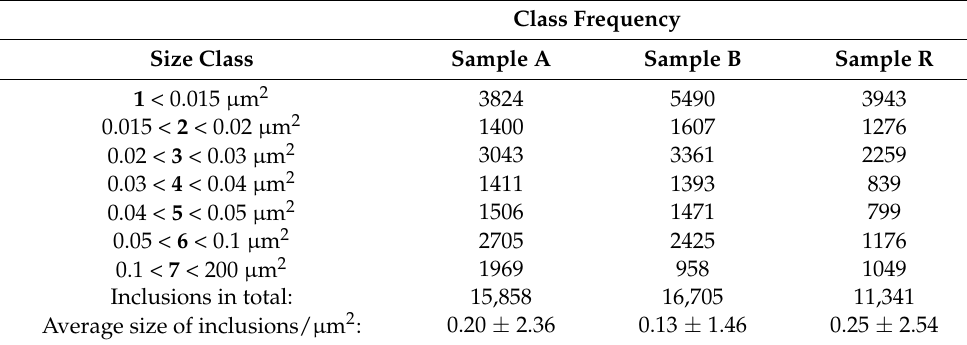
Figure 3. Number and size of inclusions in the hot-rolled steel plates A and B and the reference sample R. Table 3. Number of detected inclusions in samples A and B and reference sample R and the size class, class frequency, and average size of these inclusions.